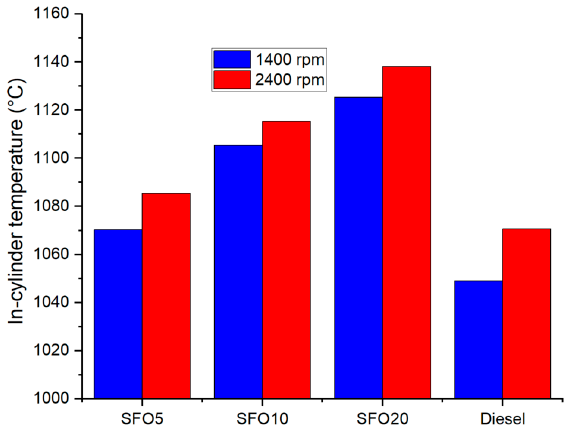
Figure 11. The average variation in the in-cylinder temperature for different fuels at 1400 and 2400 rpm.